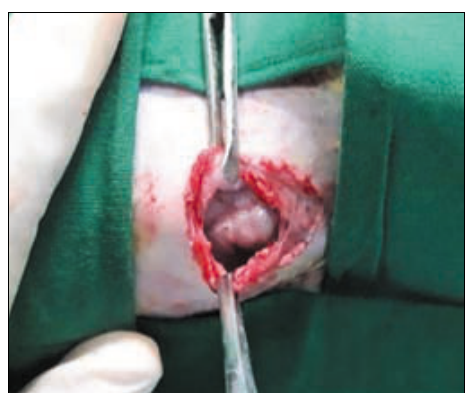
Fig. 9. Group B, Day 30th Fig. 8 . Group B, Day 10 th